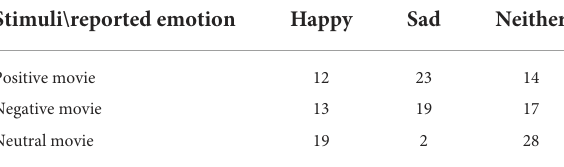
TABLE 2 Comparison of expected emotion from stimuli and reported emotion from self-reported questionnaire. Stimuli\reported emotion Happy Sad